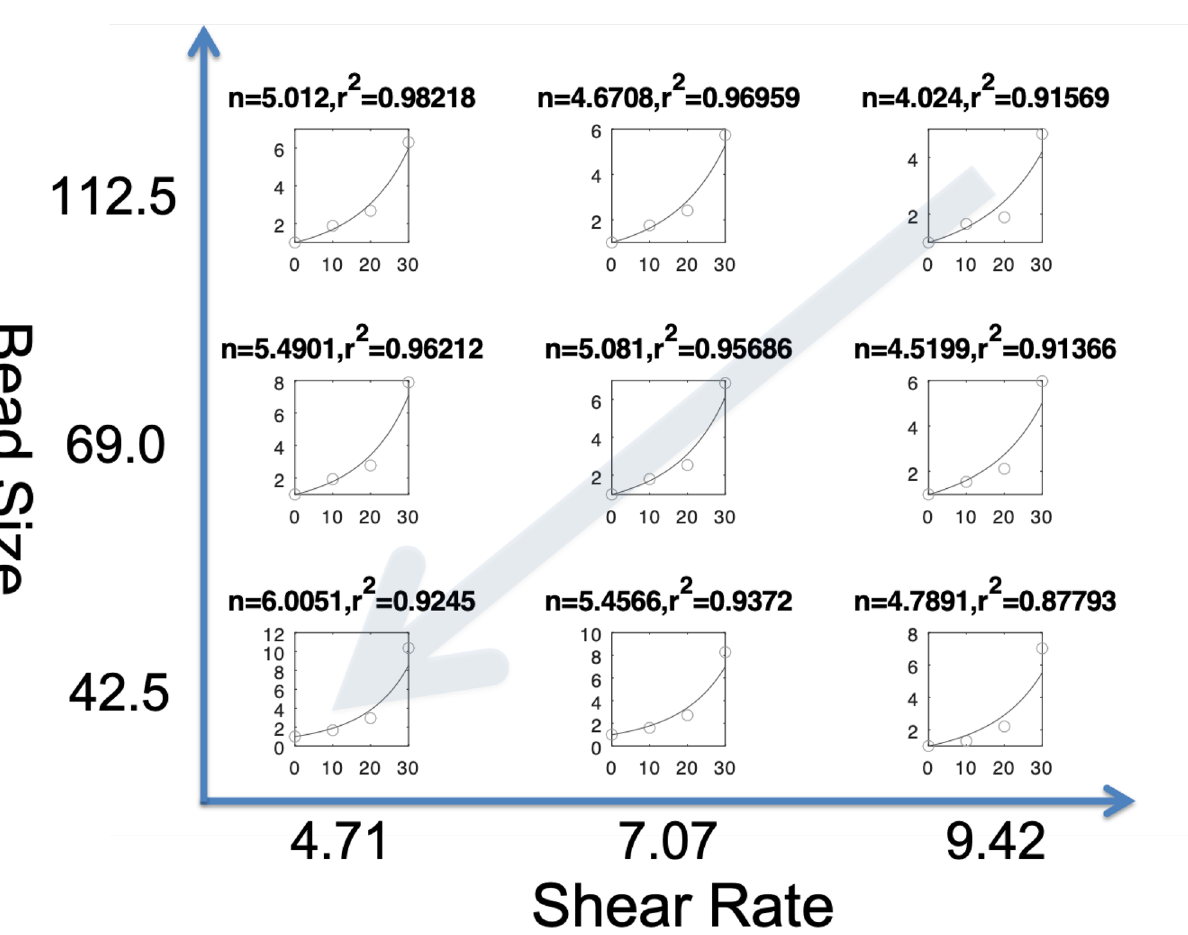
Figure 3. Least squares fitting by ERR to the high temperature slag suspension data. In each subplot, x and y axes correspond to the fraction of solid phase rate (%) and the viscosity, respectively. The fitting performance in terms of r 2 was as high as between 0.88 and 0.98 across different bead sizes and shear rates. Notice that there are linear relationships (shown as an arrow) between n and the bead size, and between n and the shear